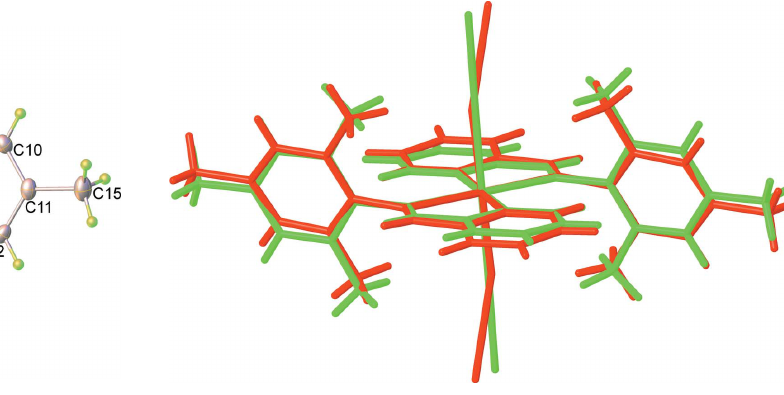
Figure 3 View of the structure overlay of ( I ) (red) and ( II ) (green).